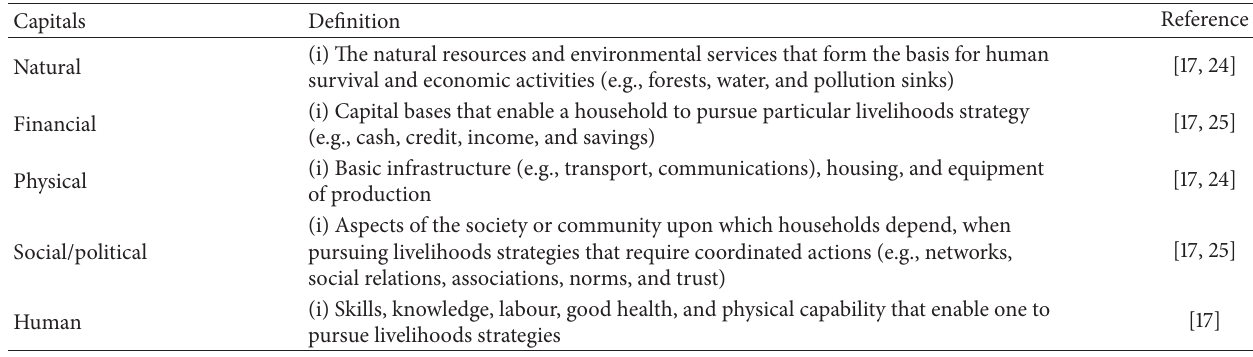
Table 1: Livelihoods capitals and their definitions.